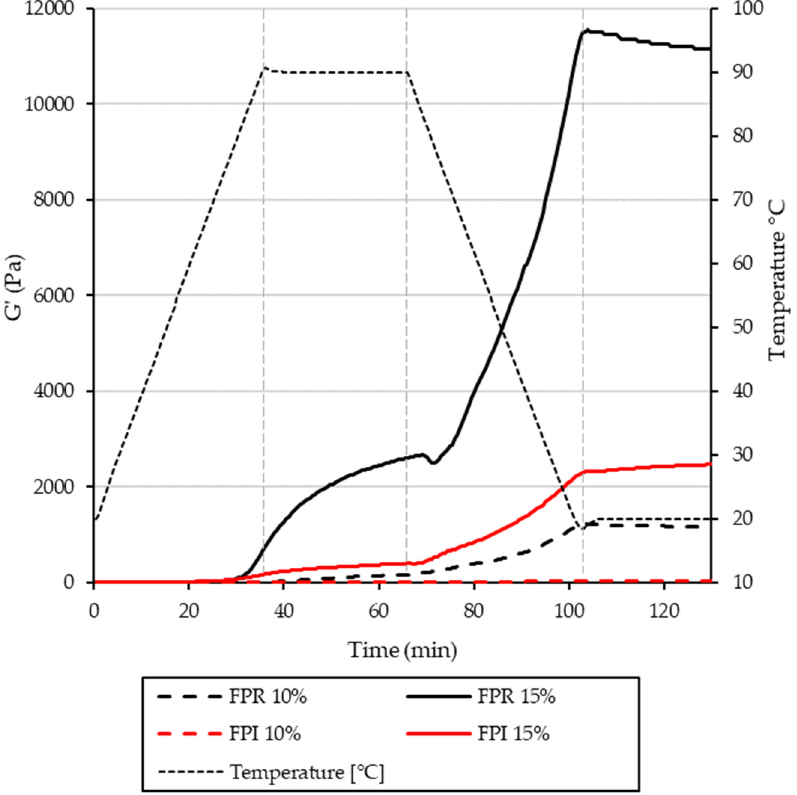
Figure 6. Rheological characterization of gel formation during heating and cooling. Storage modulus (Pa) and temperature (°C) are shown as a function of time for FPR and FPI at 10% and 15% protein.